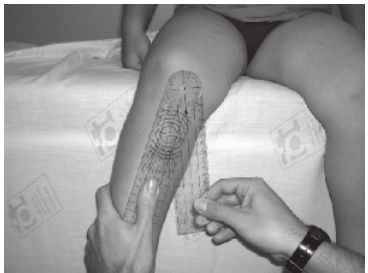
Figure 1 - Passive stretching of iliopsoas and rectus femoris muscles Figure 2 - Range of motion measurement of hip medial